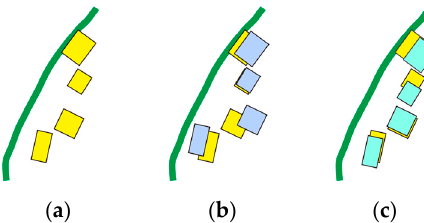
Figure 9. Building displacement results from IGA and the improved PSO: ( a ) the original buildings close to a road segment; ( b ) the IGA building displacement result; ( c ) the improved PSO building displacement result.